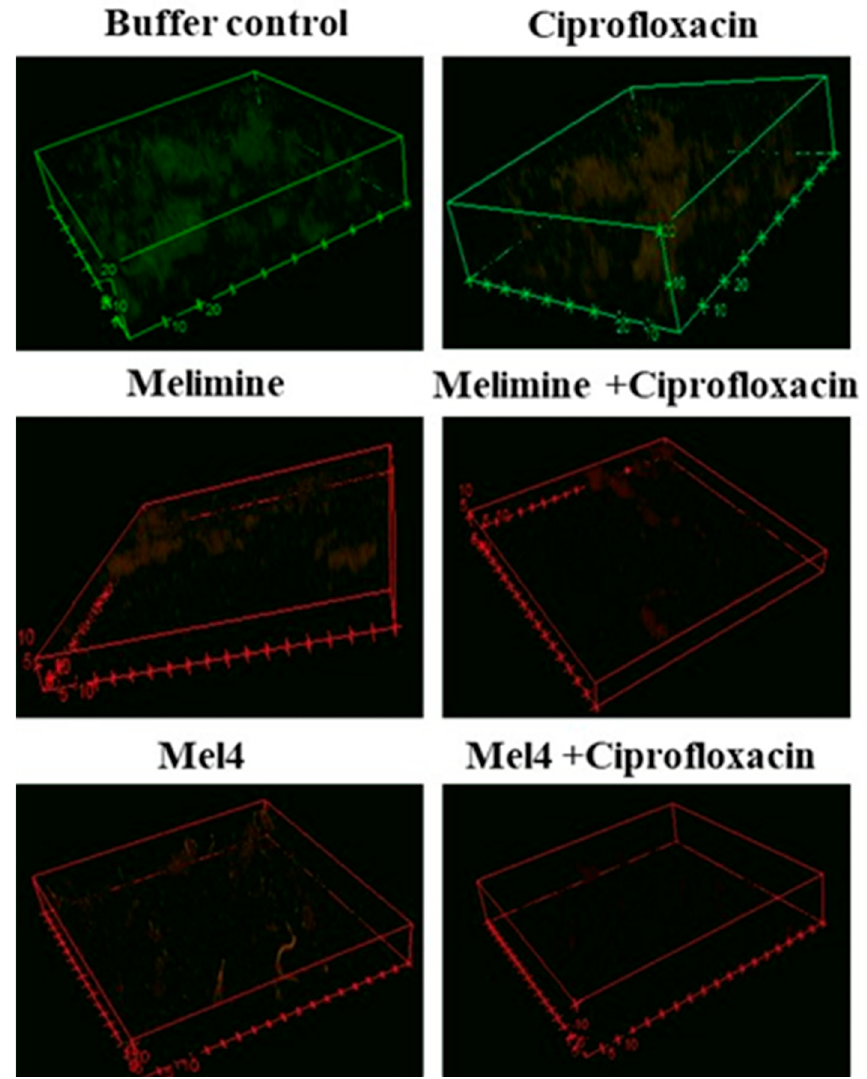
Figure 5. Representative confocal laser scanning microscopy images of biofilms of the ciprofloxacin resistant isolates of S. aureus ATCC 25923 after treatment with AMPs and ciprofloxacin alone or in combination. The antibiofilm effects were evaluated at 4X the MIC of all antimicrobials after incubation for 24 h. The biofilms of S. aureus were stained with SYTO-9 (excited at 488, green live cells) and propidium iodide (excited at 514 mm, red dead cells). The cells exposed to ciprofloxacin alone when excited at 514 nm had a reddish color indicating some of the cells had taken up the propidium iodide.